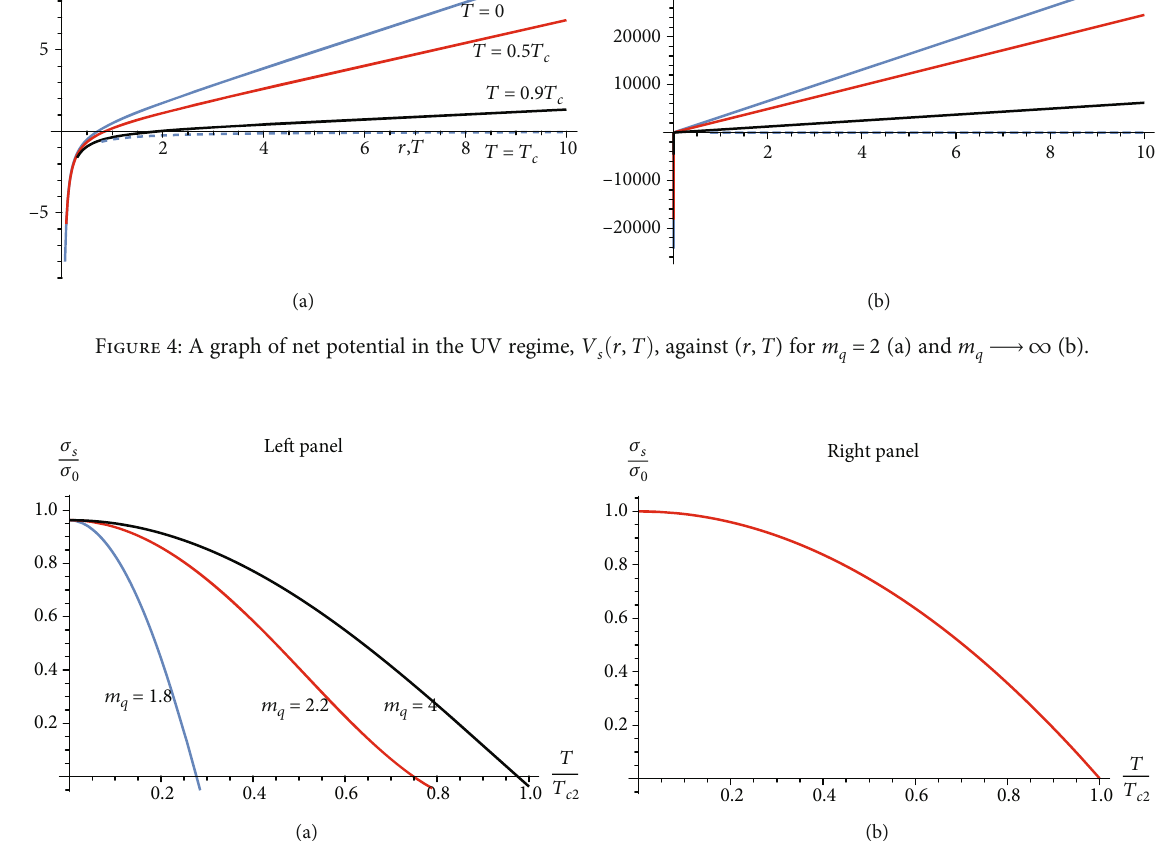
Figure 5: A graph of string tension, σ